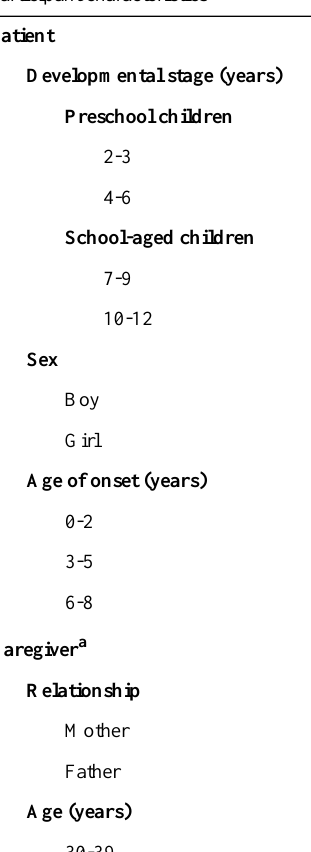
Table 1. Participants’characteristics.